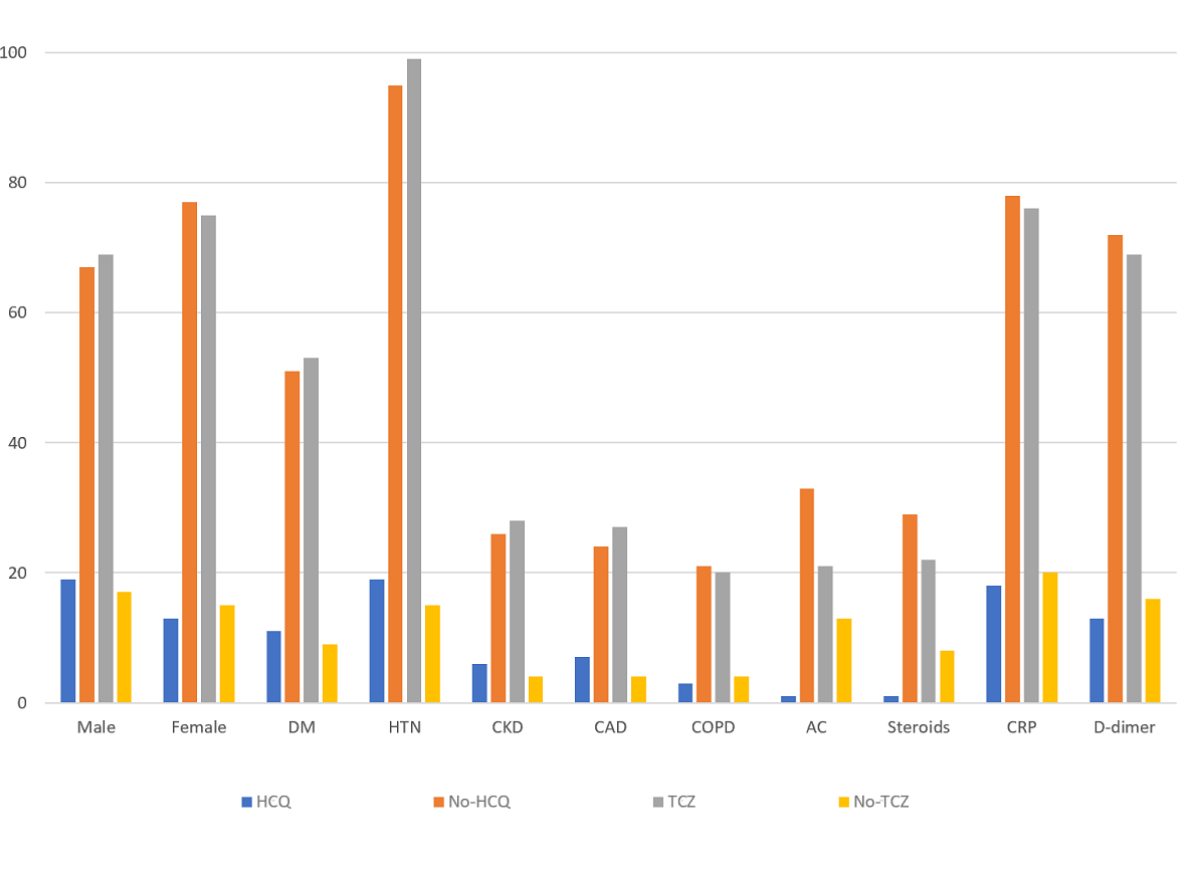
Figure 1. Baseline comorbidities and medication use in the hydroxychloroquine (HCQ) group, tocilizumab (TCZ) group, and control groups. The x-axis represents sex, comorbidities, medications, C-reactive protein (CRP), and D-dimer level at presentation; the y-axis represents the percentage of subjects. DM: diabetes mellitus; HTN: hypertension; CKD: chronic kidney disease; CAD: coronary artery disease; COPD: chronic obstructive pulmonary disease; AC: